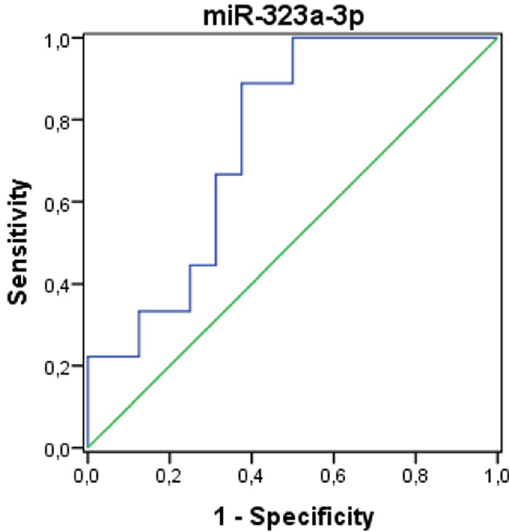
Figure 3. Area under curve of receiver operating characteristic (ROC curve for